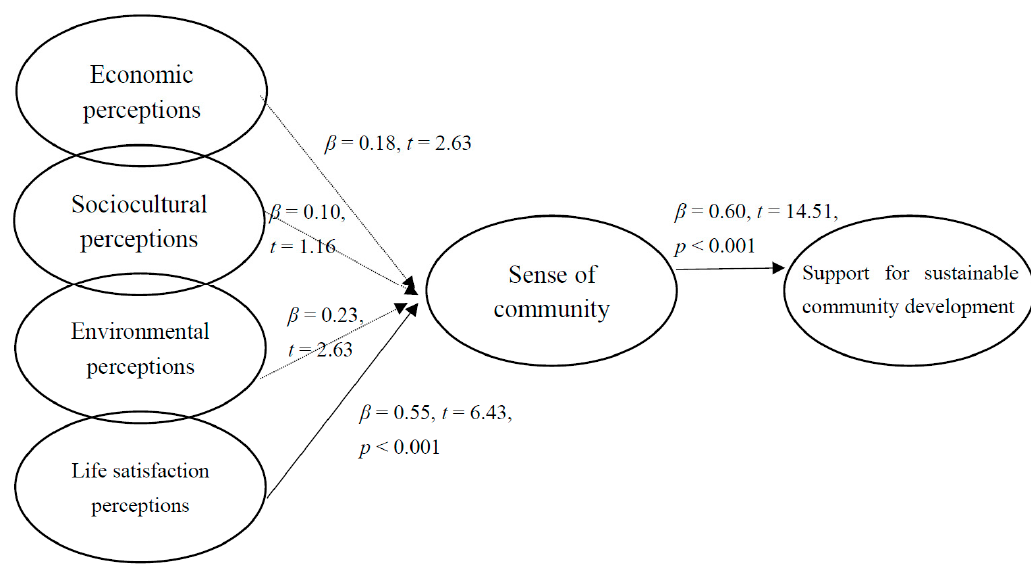
Figure 2. Structural model for Rinari.